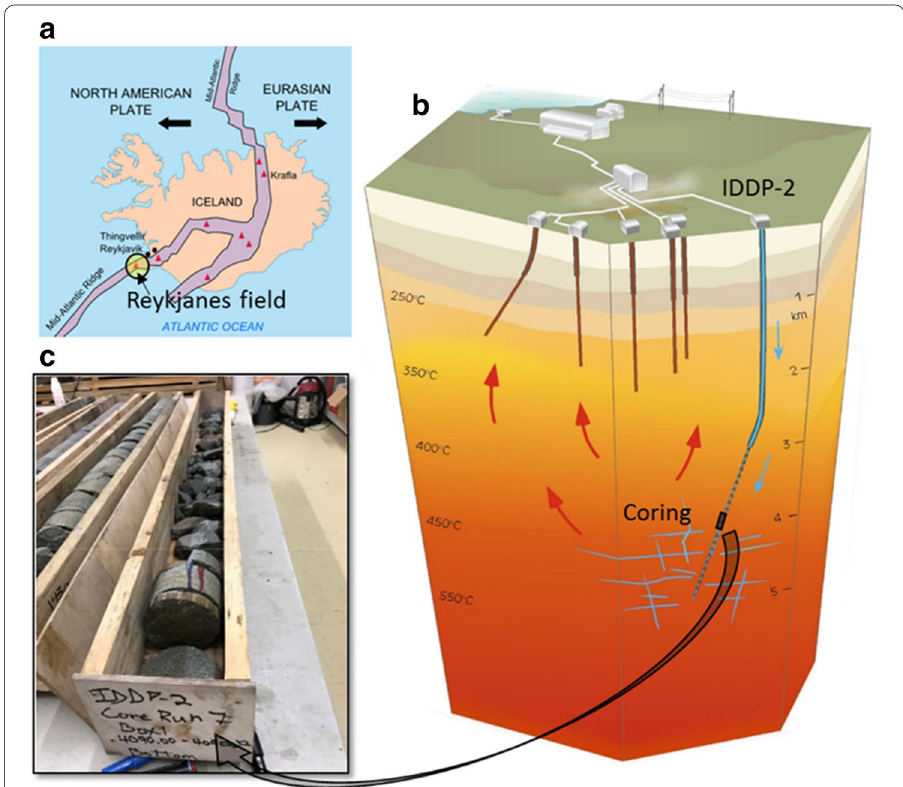
Fig. 1 a Map of the major deformation zones in Iceland and Reykjanes field location. The purple area corresponds to the Mid‑Atlantic Ridge. Red triangles correspond to the locations of some Iceland’s active volcanoes. b The RN‑15/IDDP‑2 wellbore configuration (modified from Friðleifsson et al. 2016). The blue arrows symbolize the injection of cold fluid while the red ones symbolize the moving of warmed fluid to the production wells. c Picture of the dolerite cored at 4‑km depth (courtesy of HS